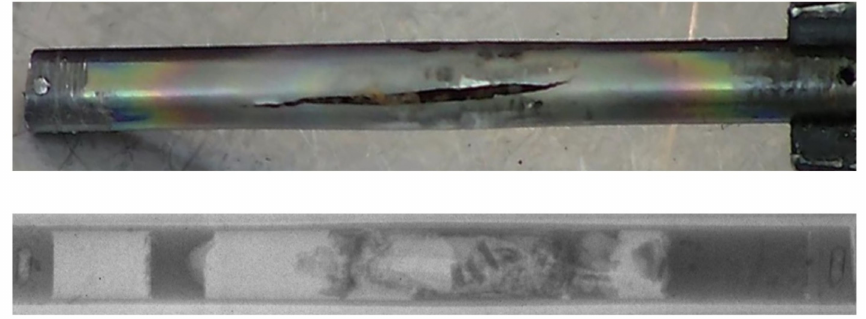
Figure 13. Photograph and radiography of damaged target rod (outer diameter approximately 10 mm) with remaining lead